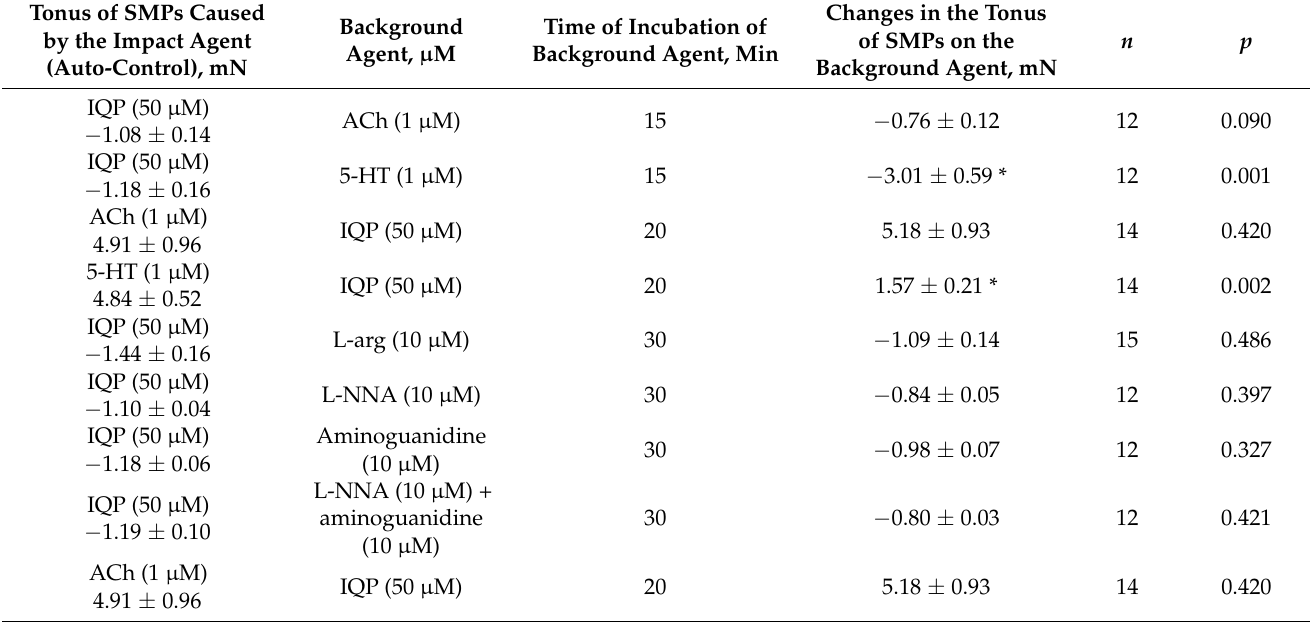
Table 1. Mutual influence on the CA caused by IQP and exogenous drags on rat circular gastric SMPs (auto-control). The comparison is between the auto-control and interaction of exogenous reagents; * p <